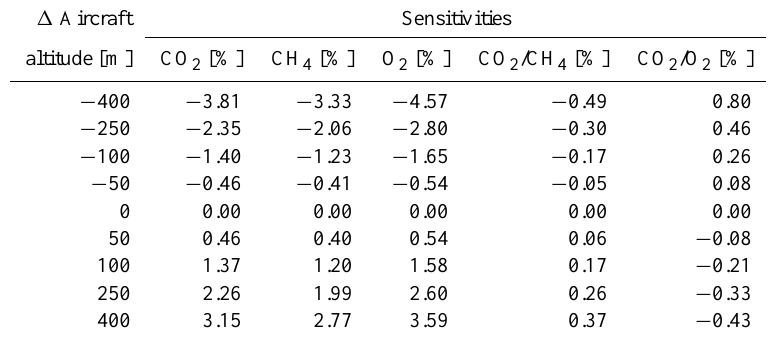
Table 7. Sensitivity to aircraft altitude sensitivity uncertainty for an albedo of 0.18 and a reference altitude of